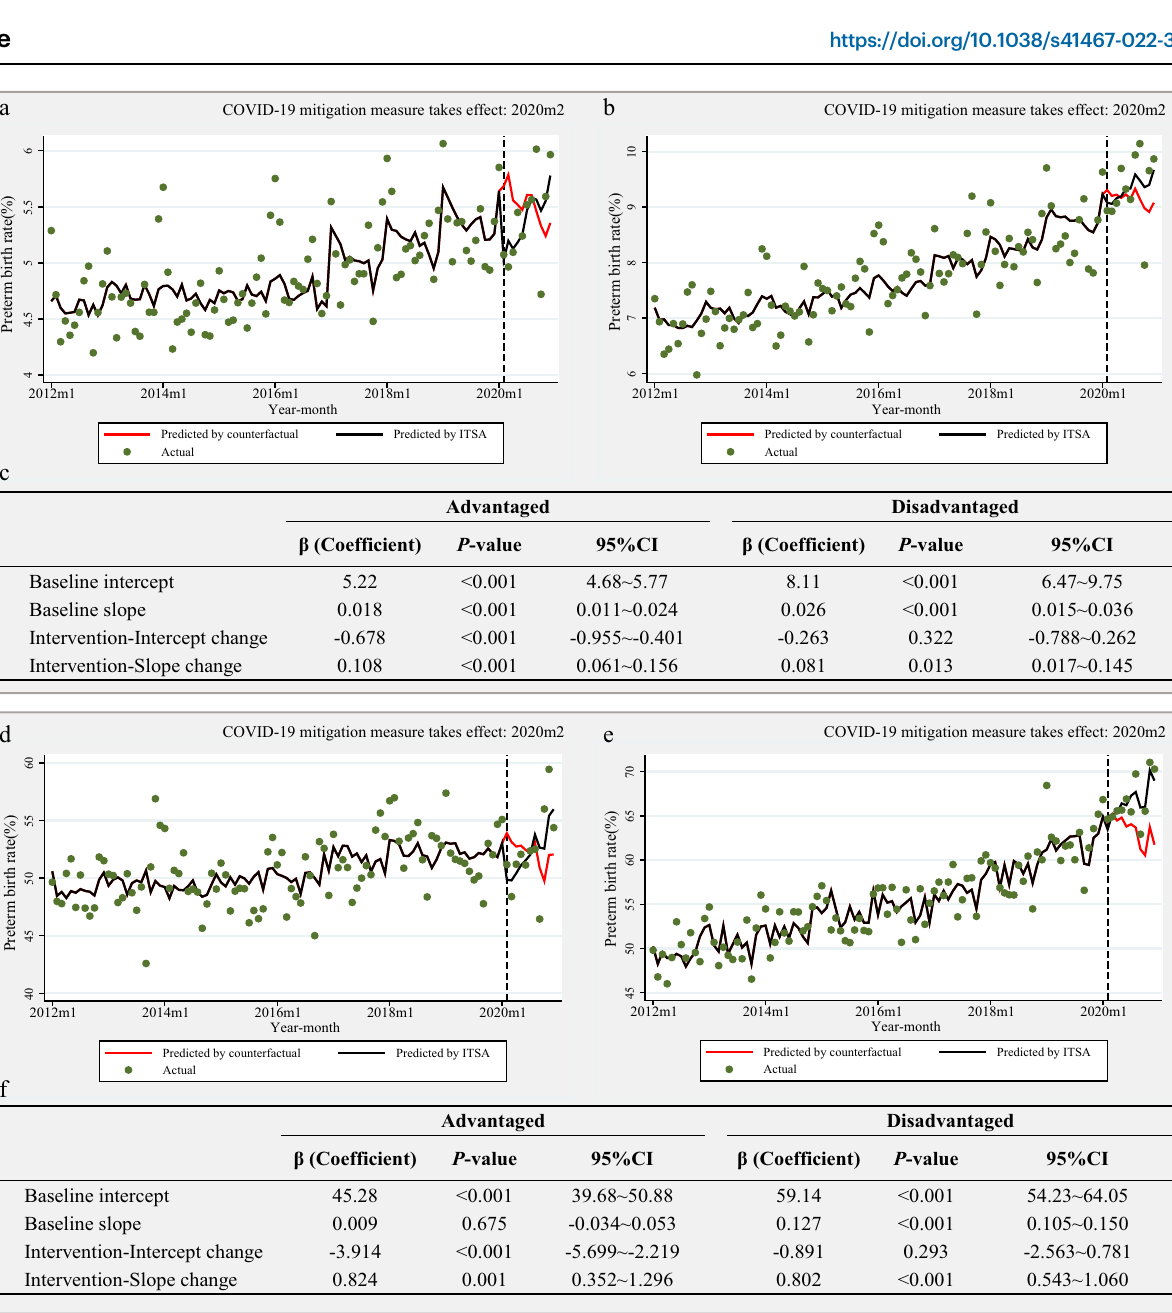
standarderrors.Womenwhowereilliterate,orhadonlyprimaryschooleducation, whowereunmarried,orwhohadfewerthan fi veantenatalvisitswerede fi nedasthe disadvantaged group. On the contrary, women with middle school or above edu- cation, married, and had more than fi ve antenatal visits were de fi ned as the advantaged group. Baseline: from January 1, 2012to January31, 2020; Intervention stage: from February 1, 2020 to December 31, 2020. Intercept change: change in level compared with the previous stage; Slope change: change in trend compared with the previous stage, per month. CI con fi dence interval, COVID-19 Coronavirus disease 2019. The p values are